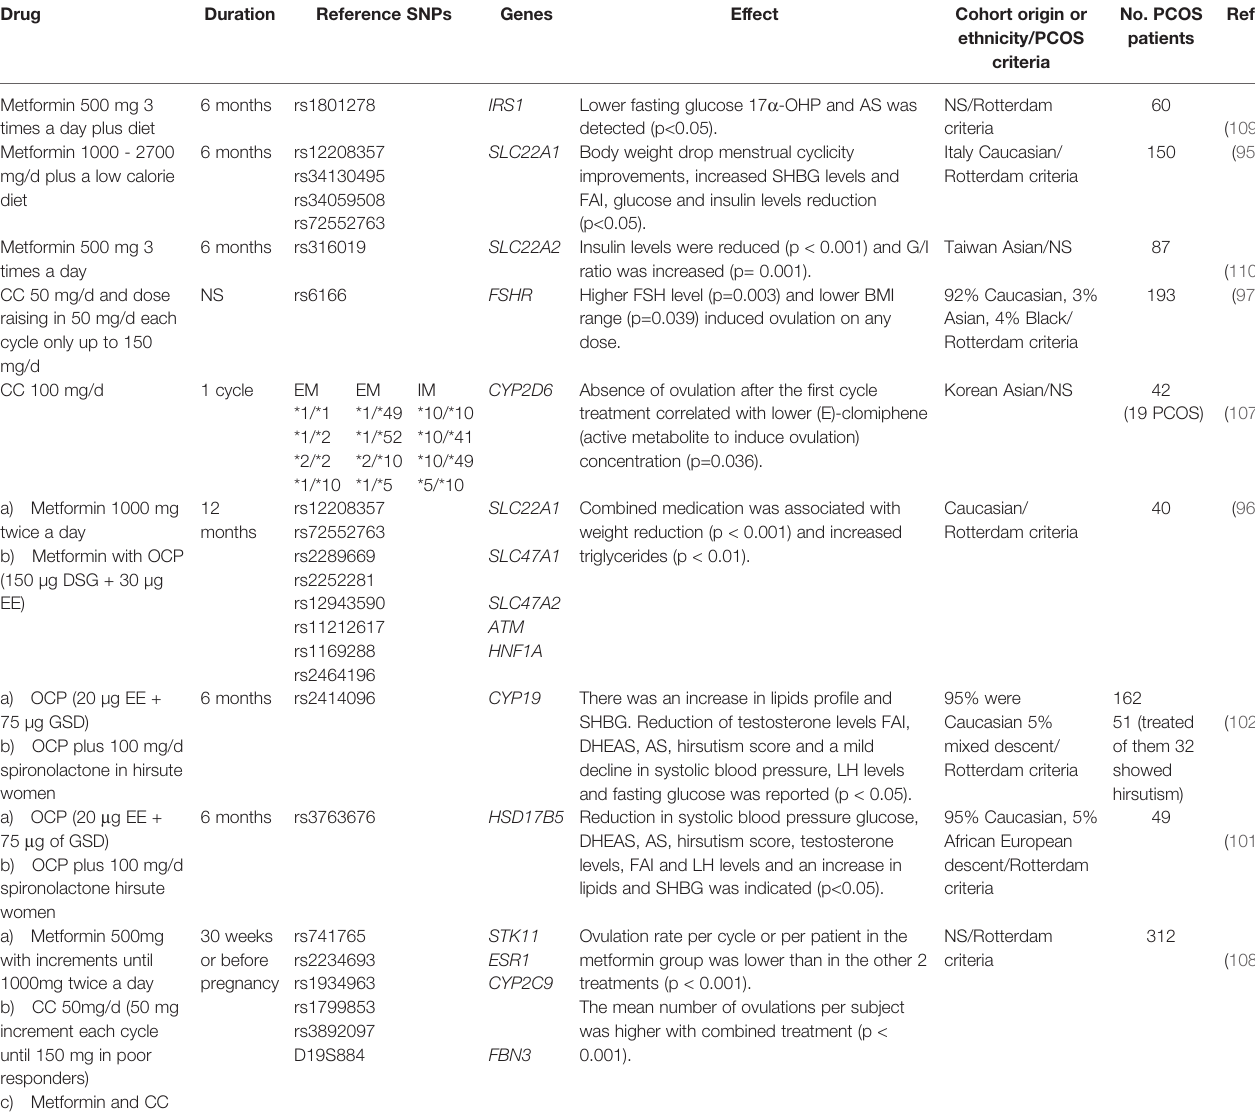
TABLE 4 | Studies with clinical improvements due to drug